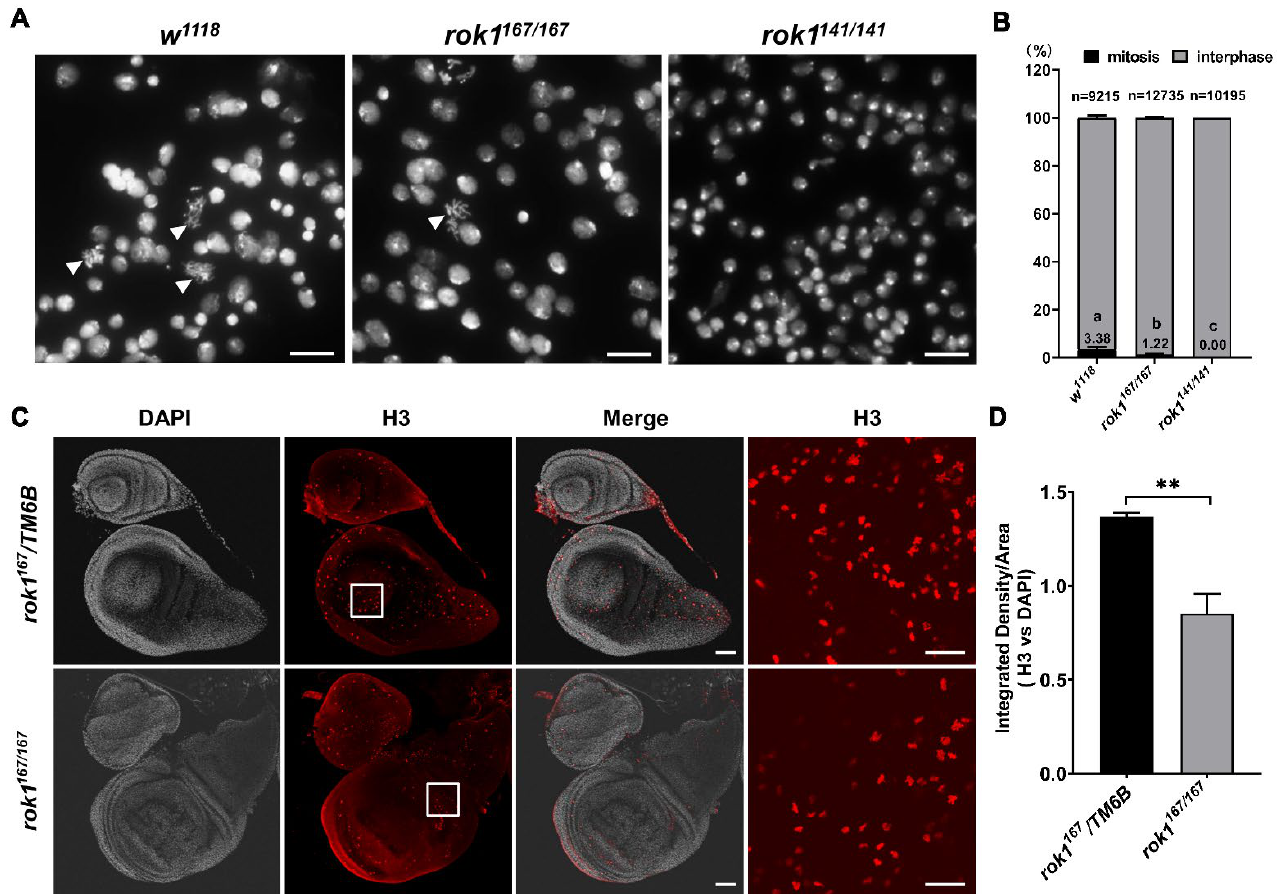
Figure 5. Loss of Rok1 inhibits mitosis in the brain. ( A ) Squashed brains from rok1 mutant larvae. Brains from third-instar larvae of w 1118 and rok1 167/167 , and second-instar larvae of rok1 141/141 were dissected. Chromosomes marked with an arrow indicate mitosis. Scale bar indicates 10 µ m. ( B ) Quantification of the “mitosis” phenotype in each genotype. Different letters indicate significant differences in percentages of cells in mitosis between various groups ( p < 0.05, LSR, SPSS). ( C ) Immunostaining of wing discs with an anti-phospho-Histone H3 antibody in rok1 mutant. Wing discs of rok1 167 /TM6B and rok1 167/167 from third-instar larvae were dissected. Images of the areas marked with solid rectangles are shown as inserts on the right. Scale bar indicates 20 μm. ( D ) Mean ratios of fluorescence density of H3. Each point represents the mean ± SD ( n = 9). ** indicate significant differences between the two groups at the p < 0.01 (unpaired t -test, SPSS).